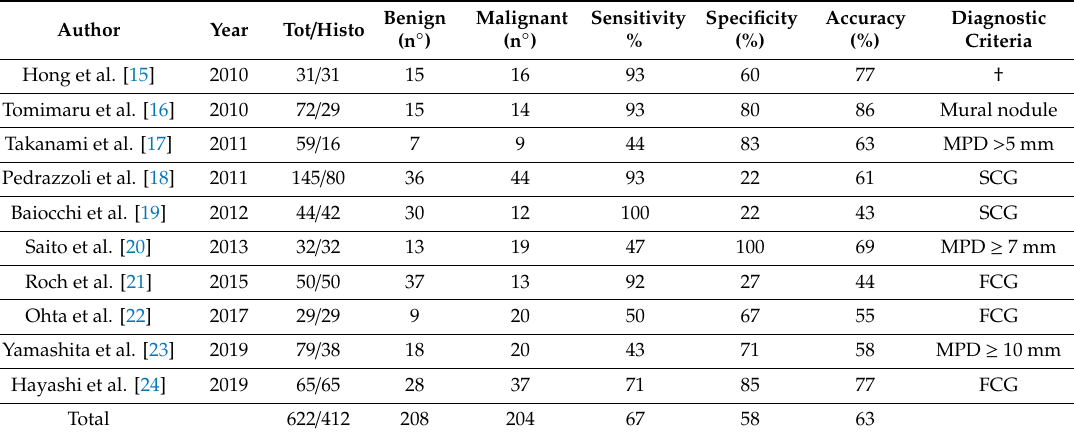
Table 3. Summary of diagnostic performance of International Guidelines. Tot: number of patients analyzed; Histo: number of patients with histopathological diagnosis available; † : main duct-type, marked dilatation of the main pancreatic duct ( ≥ 10 mm), large mural nodule ( ≥ 1 cm), large cyst size ( ≥ 3 cm), irregular or septate cyst, calcification, or patulous duodenal papilla; MPD: Main